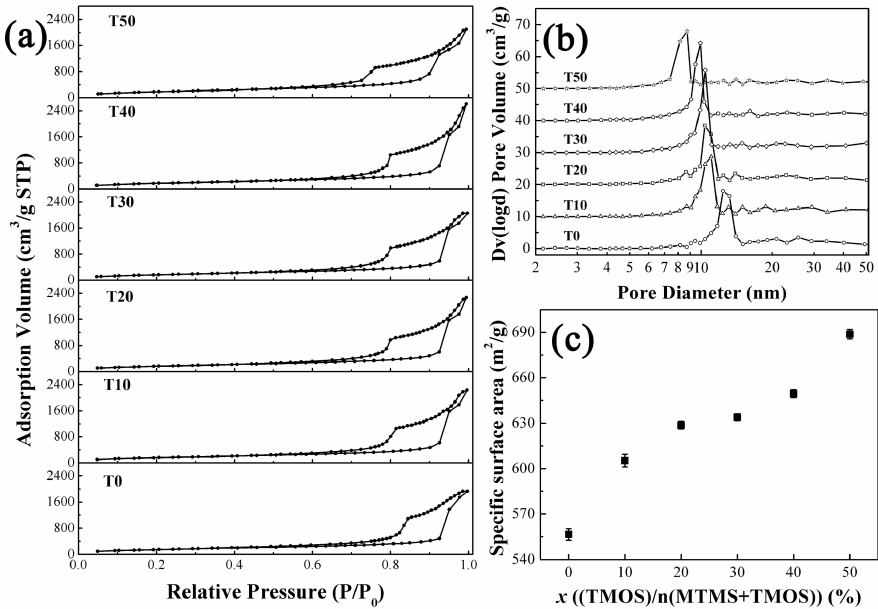
Figure 3. N 2 adsorption-desorption isotherms ( a ); the pore size distributions ( b ) and the specific surface area of the aerogels ( c